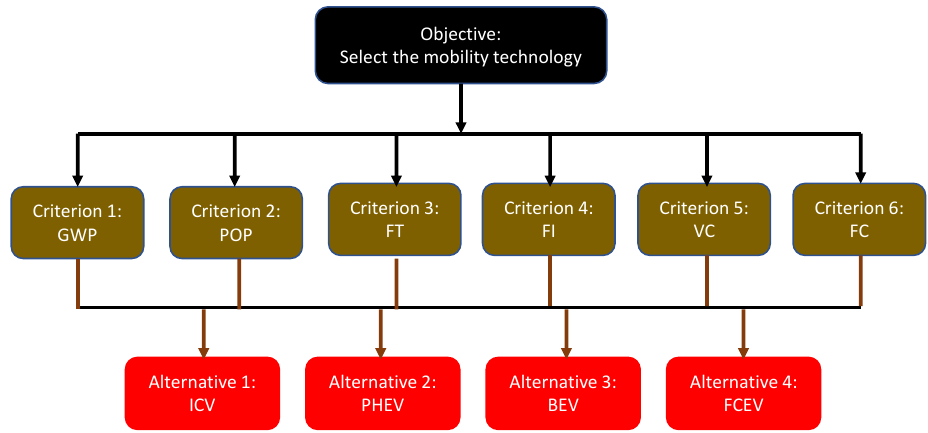
Figure 1. The hierarchical structure of the AHP method followed in this study.